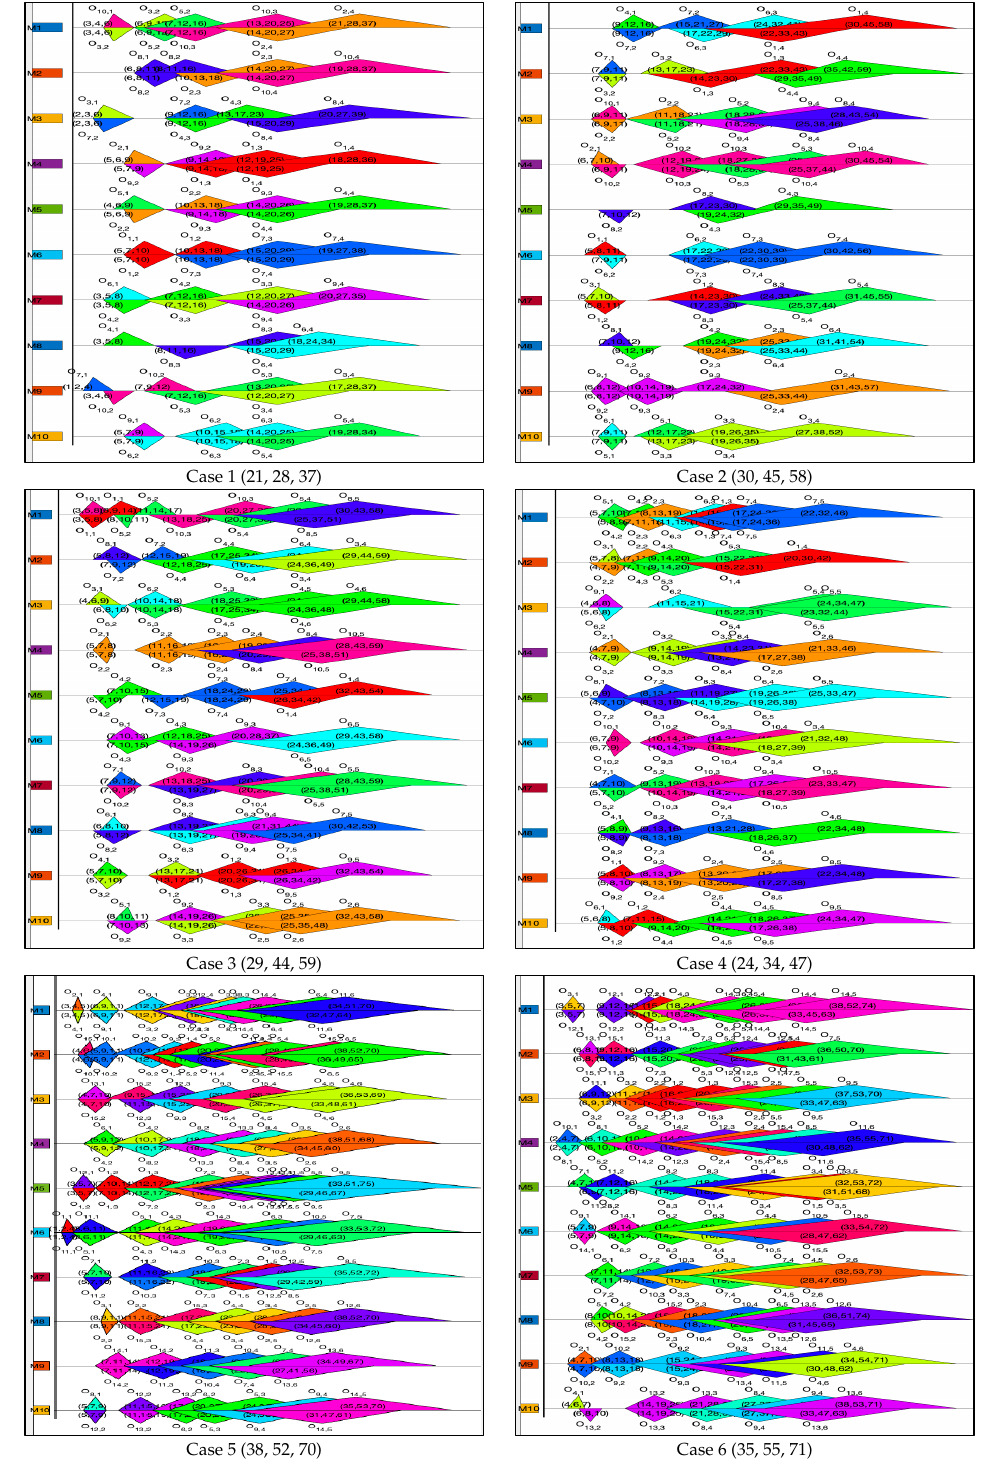
Figure 5. The best solution of Cases 1–6 obtained by the